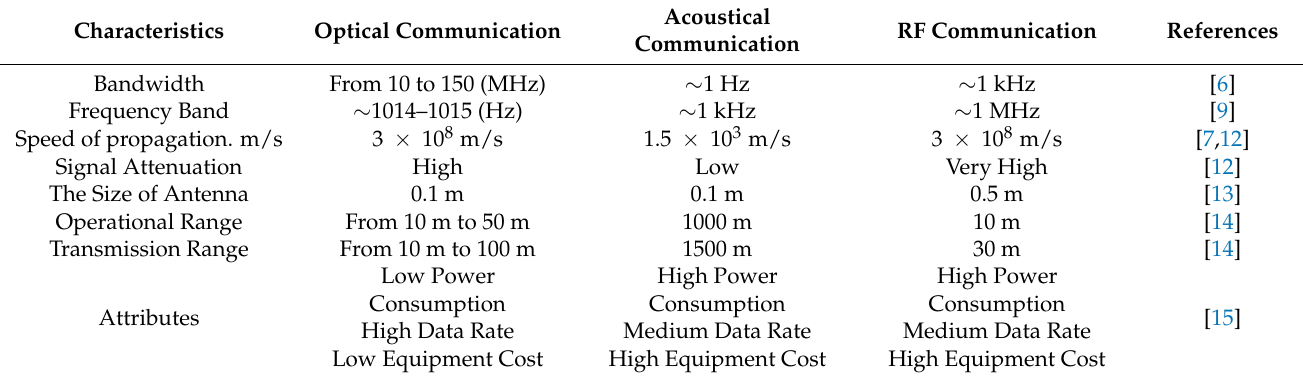
Table 2. Different features of various mediums in UWSNs.